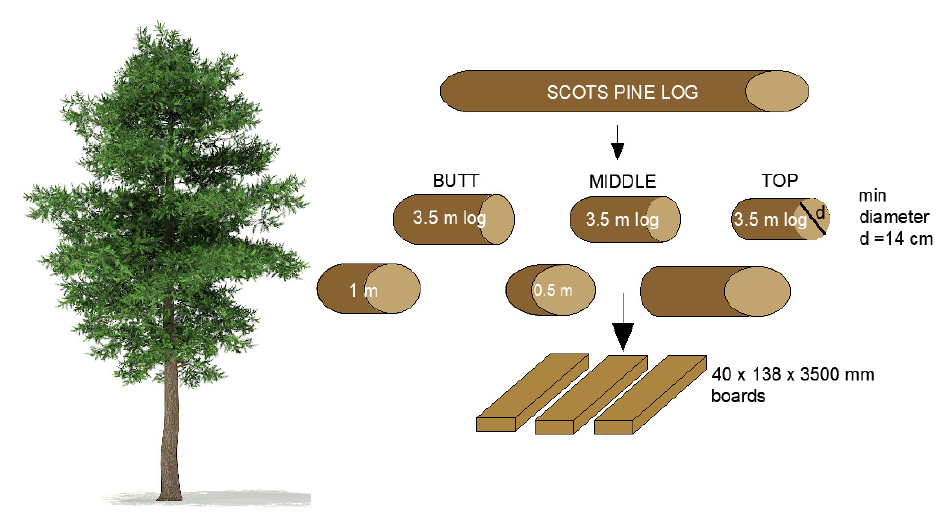
Figure 1. Diagram presenting divisions of the trunk into logs and boards.